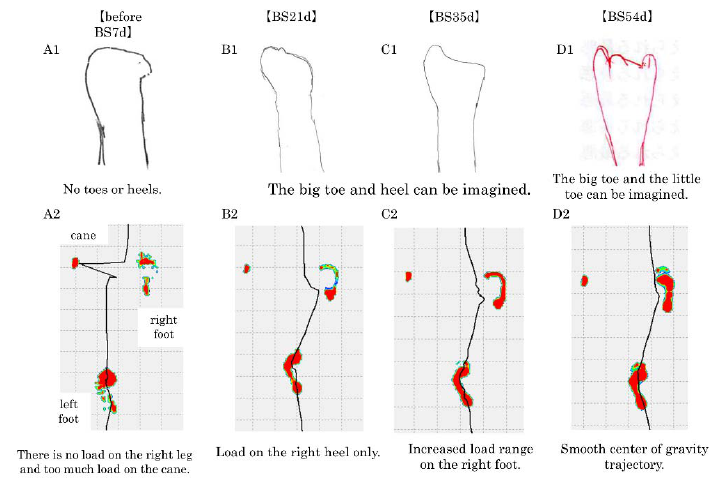
Figure 1. Changes in plantar pressure and center of gravity trajectories during self-drawing and walking. Upper figure; changes in body image (self-portrait of right foot). Lower figure; changes in plantar pressure and center of gravity trajectory. (Upwards is the direction of travel. The black line is the load line. Blue, green, yellow, and red, in this order, indicate stronger pressure.) ( A1,2 ): Before body shadow intervention 7 days (before BS2d), ( B1,2 ): After body shadow intervention 21 days (BS21d), ( C1,2 ): After body shadow intervention 35 days (BS35d), ( D1,2 ): After body shadow intervention 54 days (BS54d).